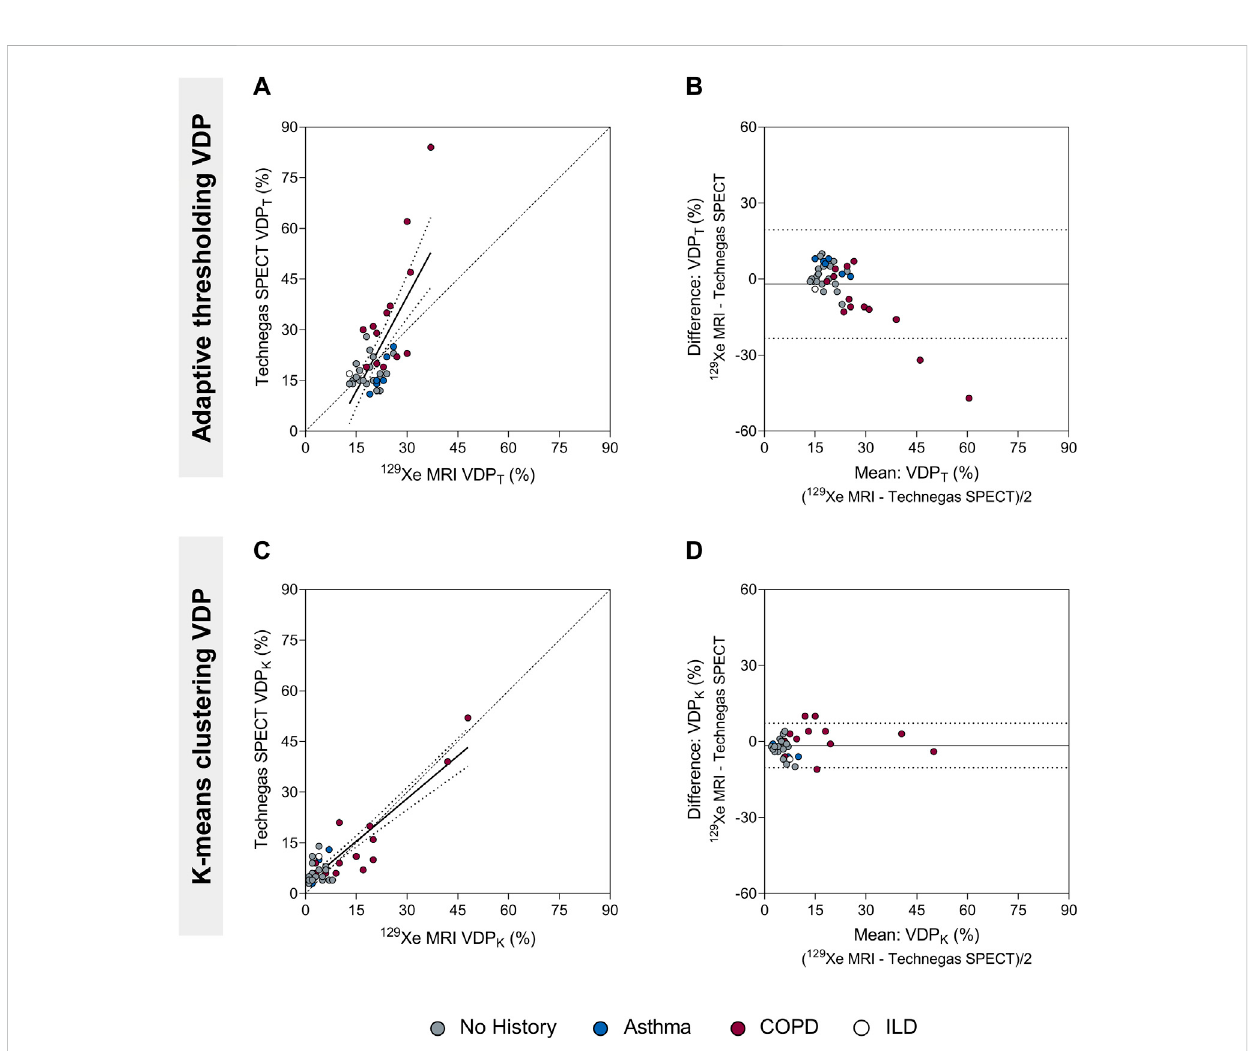
FIGURE 2 Comparison of the ventilation defect percent (adaptive thresholding (VDP T ) and k-means clustering (VDP K )) quanti fi ed by Technegas SPECT and 129 XeMRI. (A) PositiverelationshipbetweenTechnegasSPECTand 129 XeMRIVDP T quanti fi edusingtheadaptivethresholdmethod(r=0.48, r 2 =0.49, p = 0.001, y = 1.86x-16.11). (B) Bland-Altman plot of the difference between Technegas SPECT and 129 Xe MRI VDP T quanti fi ed using the adaptive threshold method.Bias= − 2.0%(95%limitsofagreement, − 23.4%to19.4%). (C) PositiverelationshipbetweenTechnegasSPECTand 129 XeMRIVDP K quanti fi ed usingthek-meansclusteringmethod(r=0.63, r 2 =0.80, p < 0.0001,y=0.84x+2.83). (D) Bland-AltmanplotofthedifferencebetweenTechnegasSPECT and 129 Xe MRI VDP K quanti fi ed using the k-means clustering method. Bias = − 1.6% (95% limits of agreement, − 10.4% to 7.2%). For correlation plots, the dashedlinerepresentsthelineofidentity(y=x)andthedottedlinesrepresentthe95%con fi denceintervalsofthelinearregressionline.ForBland-Altman plots, the solid line represents the mean of the paired differences, and the dotted lines represent the 95% limits of agreement. Colored data points represent history of lung disease (no history, n = 21; asthma, n = 6; COPD, n = 13; ILD: n = 1). *Thresholding (VDP T ) and k-means clustering (VDP K ) methods previously optimized and validated for Technegas SPECT and 129 Xe MRI,